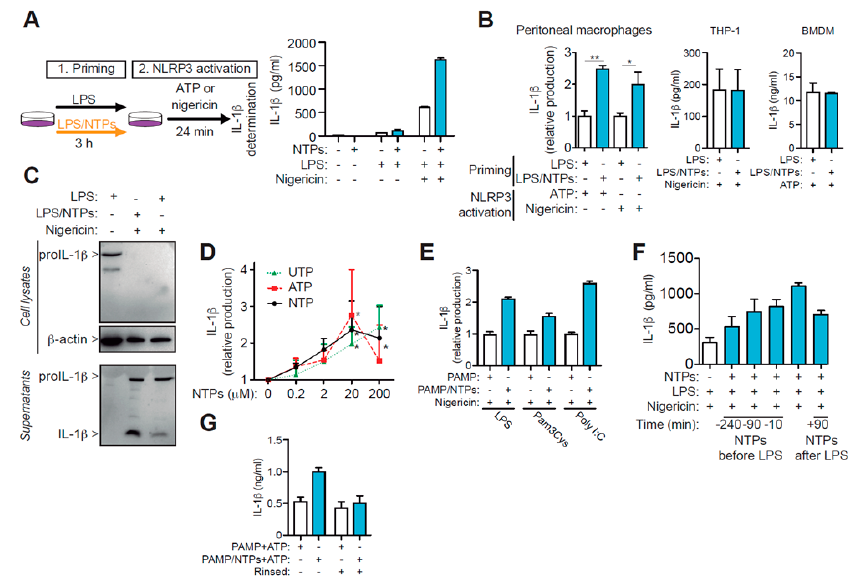
Figure 1. Nucleotides increase LPS-primed IL-1 β production. ( A ) Schematic representation of the protocol employed to activate the NLRP3 inflammasome (left). Representative analysis of IL-1 β produced by peritoneal macrophages (RPM) plated in duplicates at 0.3 × 10 6 cell / mL and primed with LPS, in the absence (white) or presence (blue) of 100 µ M ATP and UTP (NTPs) for 3h and then the NLRP3 inflammasome was activated with nigericin; bars indicate + SD. ( B ) IL-1 β production from RPMs, mouse bone marrow derived macrophages (BMDM) or THP-1 cells primed with LPS in the absence (white bars) or presence (blue bars) of nucleotides when NLRP3 was activated with ATP or nigericin as indicated; average + SEM of 12 and eight experiments, respectively, is shown for RPMs, one representative experiment out of n = 3 di ff erent experiments for BMDM and n = 2 for THP-1. ( C ) Representative analysis by Western blot of cell lysate and supernatants of macrophages primed with LPS only (left and right lanes) or LPS with NTPs (middle lane) and then activated with nigericin as indicated. ( D ) Dose-response e ff ect of nucleotides priming with LPS on IL-1 β production as indicated in ( A ); data is normalized to IL-1 β production of RPMs primed with LPS absence of nucleotides and shows the average of three experiments + SEM. ( E ) IL-1 β production in supernatants from RPMs primed with the indicated PAMP in the presence (blue bars) or absence (white bars) of NTPs (20 µ M UTP / ATP) for 3 h and following NLRP3 activation with nigericin. One experiment + SD out of three is shown. ( F ) Kinetic analysis on IL-1 β production when NTPs were added prior (negative values) at the same time or after (positive values) cells were primed with LPS and after 3 h NLRP3 was activated with nigericin; a representative experiment out of 2–4 is shown, bars indicate + SD. ( G ) Resting RPMs were primed with NTPs (20 µ M UTP / ATP) or not for 10 min. before adding LPS, then cells rinsed (right pair of columns) or not (left pair of columns). LPS was then added for 3h and NLPR3 inflammasome was activated using 3 mM of ATP for 24 min. Supernatants from both conditions were compared for IL-1 β production. A representative experiment of three is shown with SD. * = p < 0.05 or ** = p < 0.01 significance.